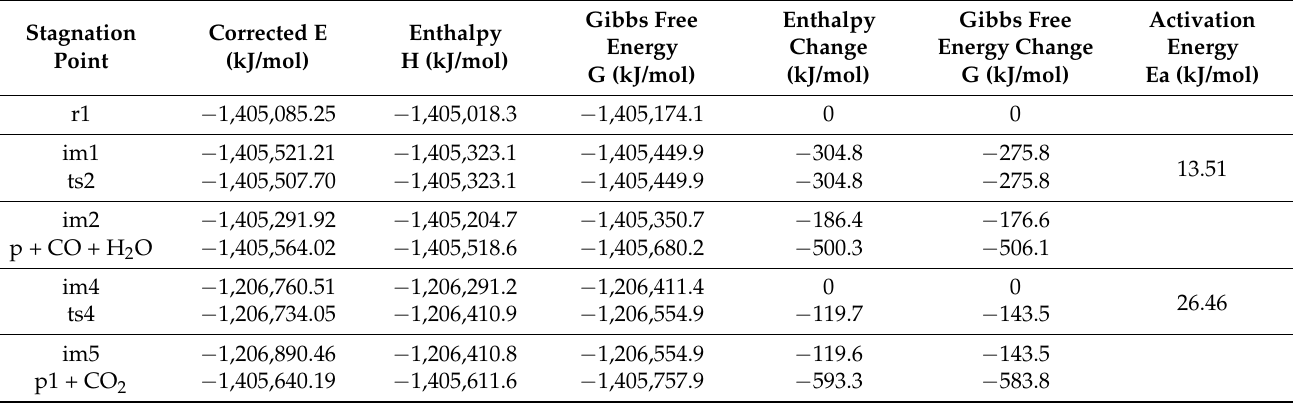
Table 3. Thermodynamic parameters of ph-CH 2 CHO with O 2 reaction.